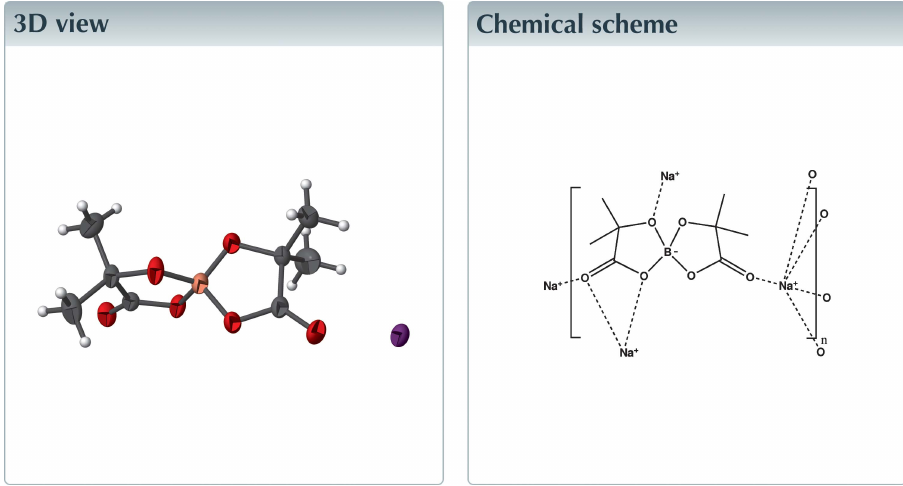
longer distances (Table 1). In the anion, the five-membered ring O2/C1/C2/O3/B1 is essentially planar [r.m.s. deviation 0.0312 A˚ , with the greatest deviation for O3